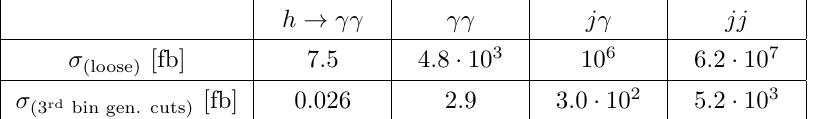
Table 8 . Parton level cross sections for signal and backgrounds before and after imposing the generation level cuts de(cid:12)ned in table 7. Signal and (cid:13)(cid:13) were generated at (0+1 j ), while j(cid:13) and jj are LO. We only show the cross section after generation cuts for the third bin. See text for more details. The subscript ‘loose’ refers to the mild cuts we had to impose to regulate infrared divergencies. We employed the cuts p j;(cid:13) > 20 GeV for all the four processes, m X > 20 GeV for T